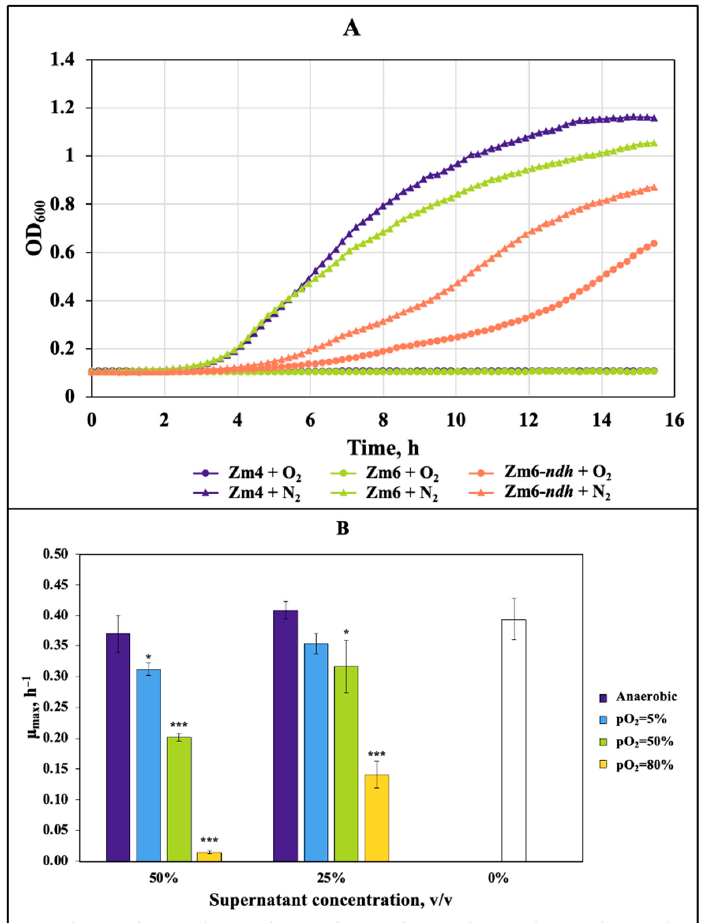
Figure 3. Effect of Z. mobilis culture aeration on the inhibitory effect of its culture supernatant on E. coli growth: ( A ) effect of Z. mobilis culture supernatants (at 50% final concentration) from aerobically or anaerobically cultivated strains Zm4, Zm6, and Zm6- ndh ; ( B ) dependence of the inhibitory properties of the supernatants from Zm4 batch cultures grown in fermenters at various set pO 2 values.